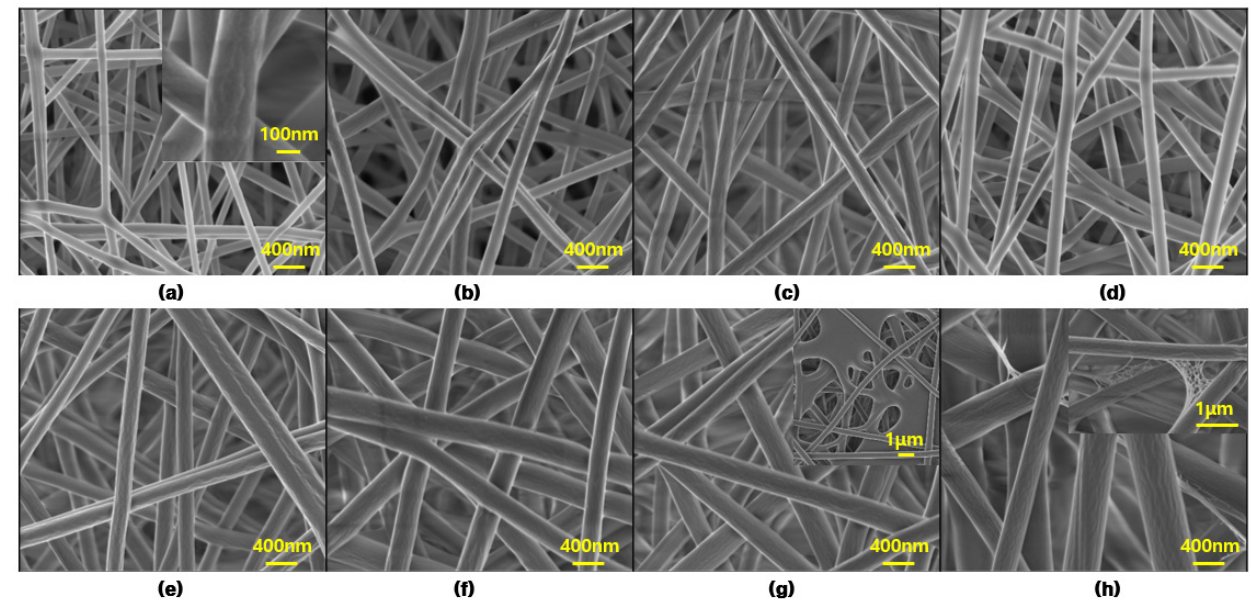
Figure 2. FE-SEM images of PVA fibers with various PVA solution concentrations: ( a ) 8 wt%, ( b ) 9 wt%, ( c ) 10 wt%, ( d ) 11 wt%, ( e ) 12 wt%, ( f ) 13 wt%, ( g ) 14 wt%, ( h ) 15 wt%.